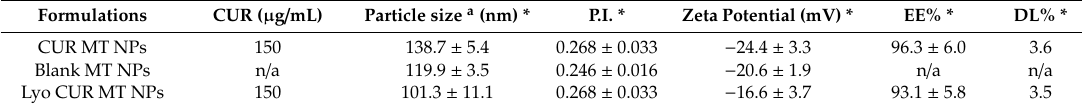
Table 2. Physico-chemical properties of CUR MT NPs ( n =